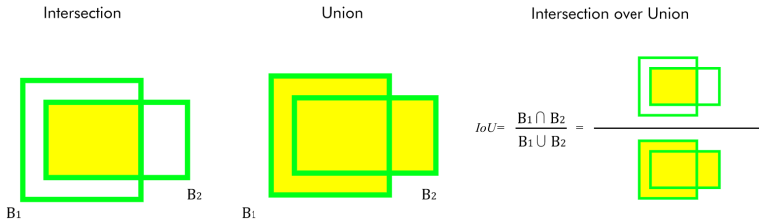
Figure 24. Intersection over Union — B1: Predication Box and B2: Detection Box (Adapted from [33,34]).